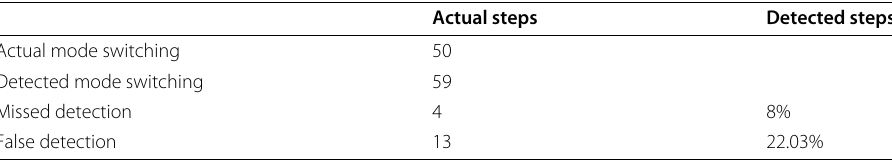
Table 1 Performance of mode switching detection algorithm